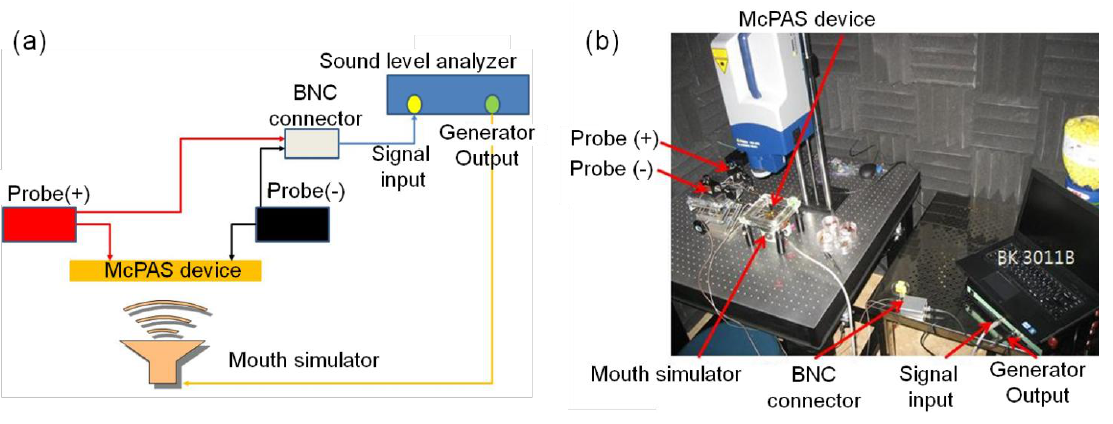
Figure 7. Schematic and picture of experimental setup for piezoelectric signal